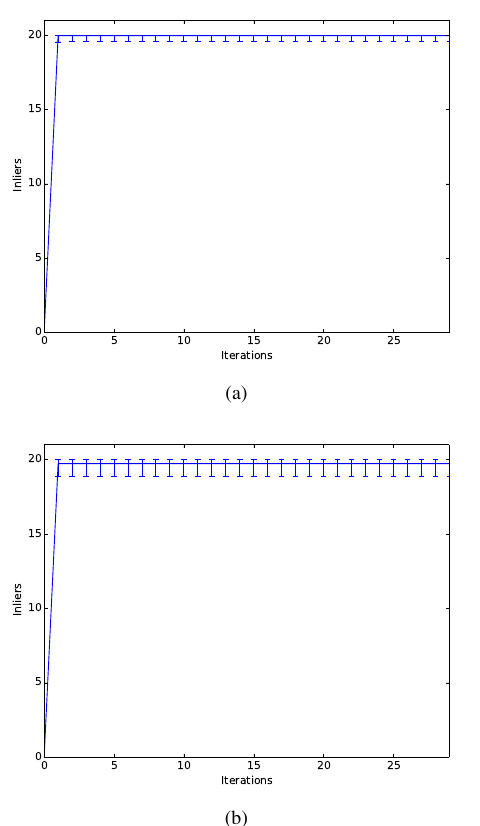
Figure 3: RANSAC-like procedure during self-calibration: Mean and standard deviation of number of inliers given the number of sampling iterations for the 25mm lens (a) and the 50mm lens (b). The standard deviation is truncated towards the top, as the num- ber of inliers can be at most 20 (the number of markers in the grid pattern).